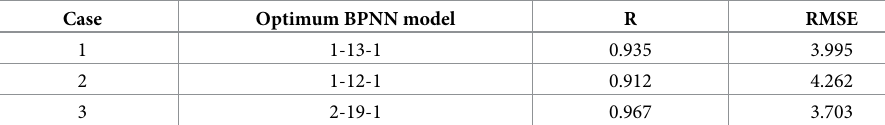
Table 11. Statistical index of different optimal BPNN structures.